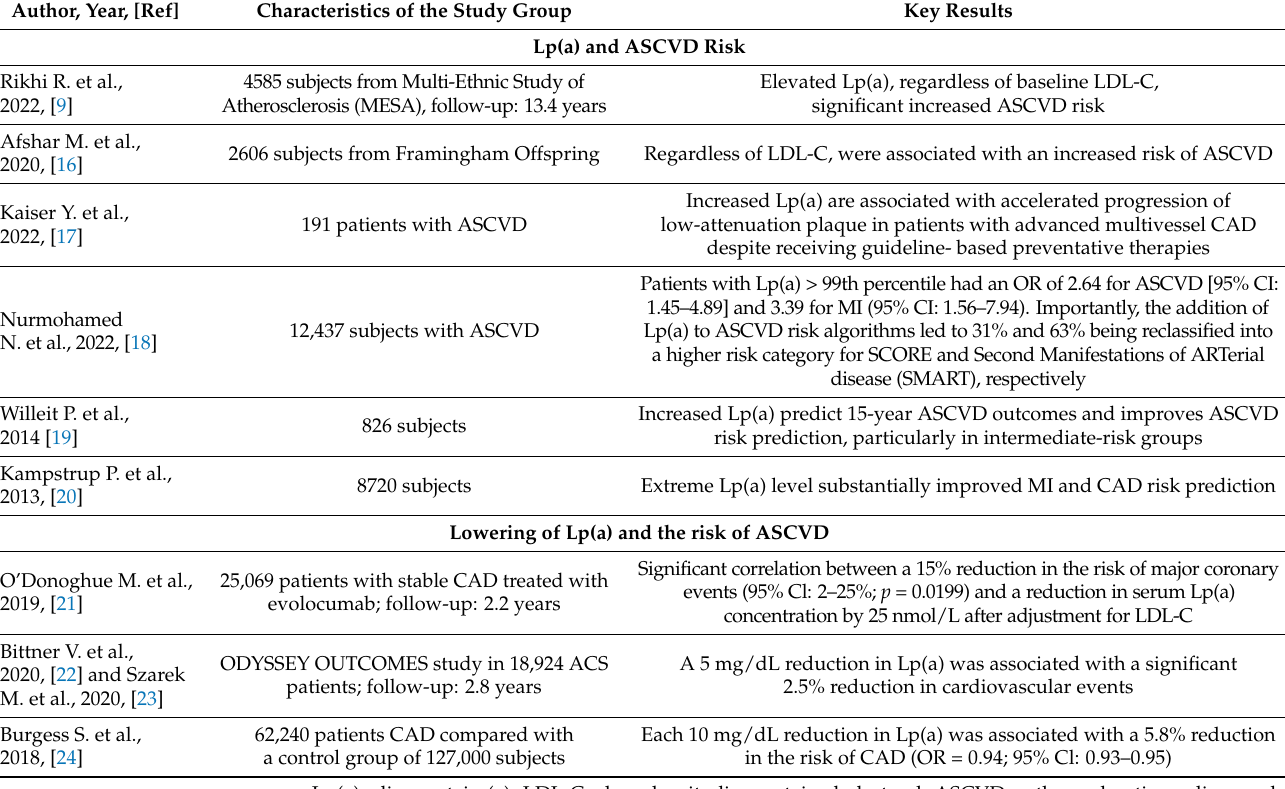
Table 1. Lp(a) serum concentrations and cardiovascular risk.